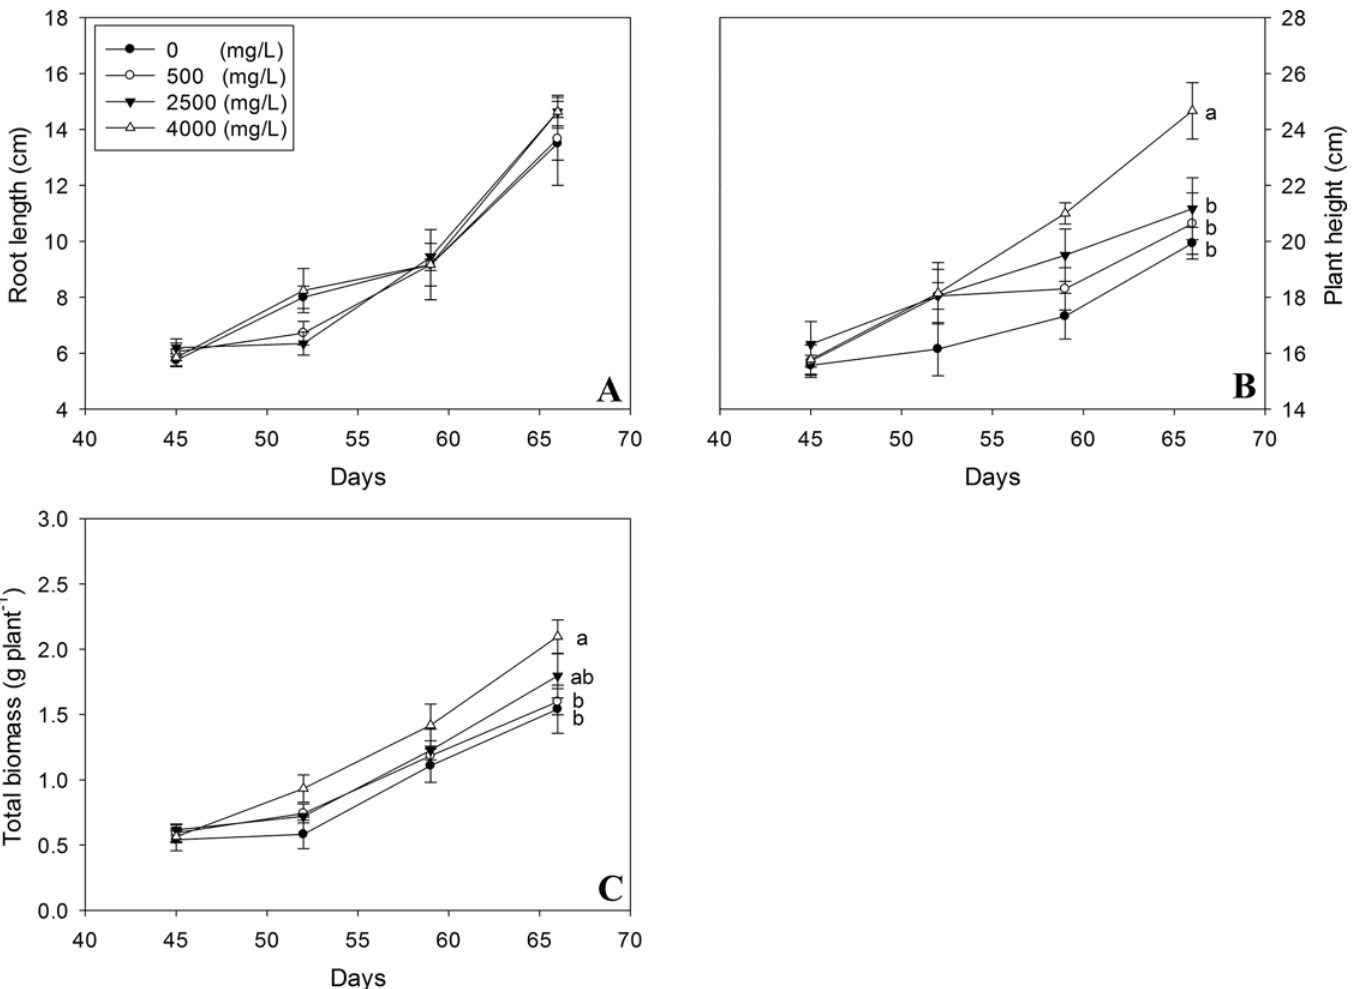
Fig 1. Effects of nano-TiO 2 on seedling growth of oilseed rape. Results are shown as an average of measurements for five plants. Means with the same lowercase letters are not significantly different at P < 0.05. Vertical bars represent ± SE.